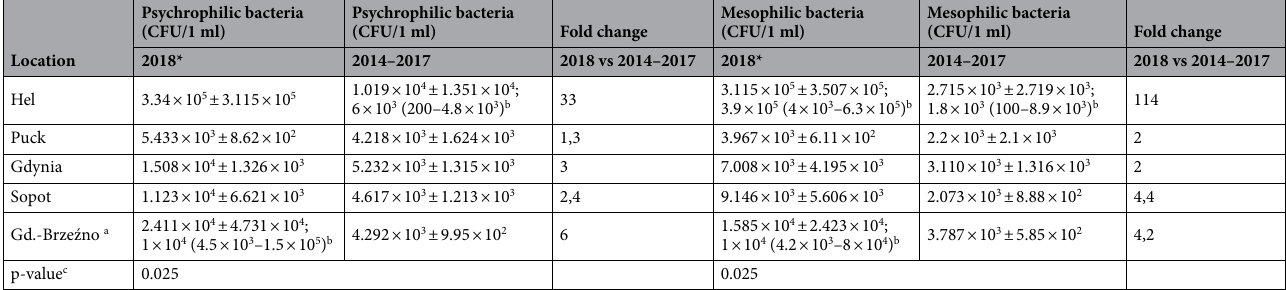
Table 1. The mean and standard deviation of concentration of psychrophilic and mesophilic bacteria (CFU/1 ml) in sea-surface microlayer samples collected in the Bay of Gdańsk in 2018 versus 2014–2017. a Gd.- Brzeźno—it is an abbreviation of the town name Gdańsk-Brzeźno, b in case of a higher standard deviation than the mean, the median and range (min–max) was calculated, c Friedman test, α-0.05, *The results marked in grey colour have been published in preliminary study 36